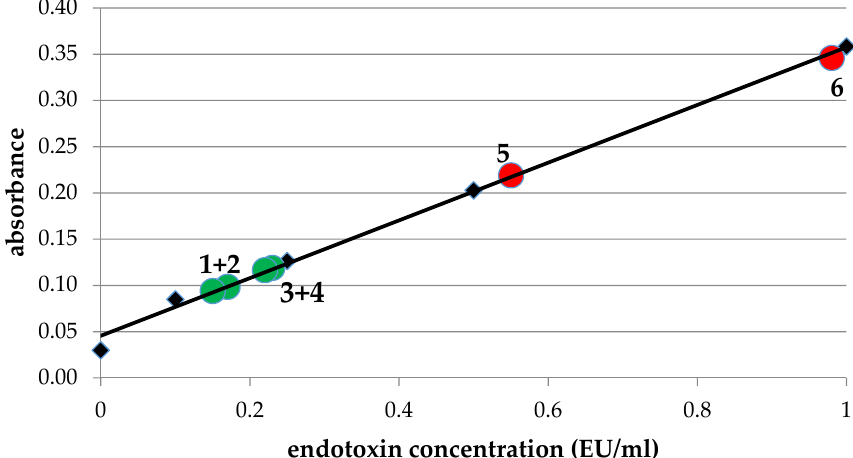
Figure 2. Determination of endotoxin concentration in PLA disks. Endotoxin concentration was determined in supernatants of PLA strings before printing directly after unpacking (red circle 5) and after a few days at the air (red circle 6) and in PLA disks after printing incubated for 24 h (1 + 2) or 48 h (3 + 4): green circles. The trendline corresponds to standards with 0.1, 0.25, 0.5 and 1.0 EU/mL (black quarders). The diagram shows that endotoxin concentrations are well below the FDA limit of 0.5 EU/mL.